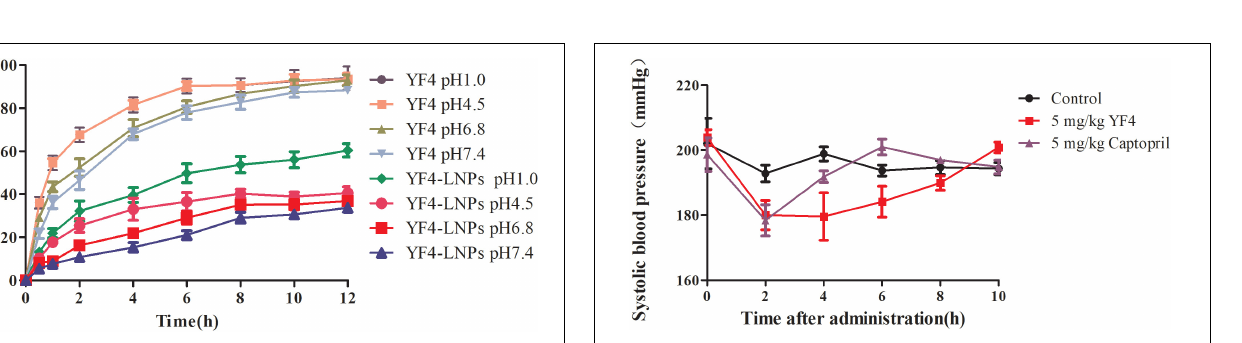
FIGURE 4 | Release profiles of free YF4 and YF4-LNPs in different phosphate buffers (pH1.0, 4.5, 6.8, and 7.4).